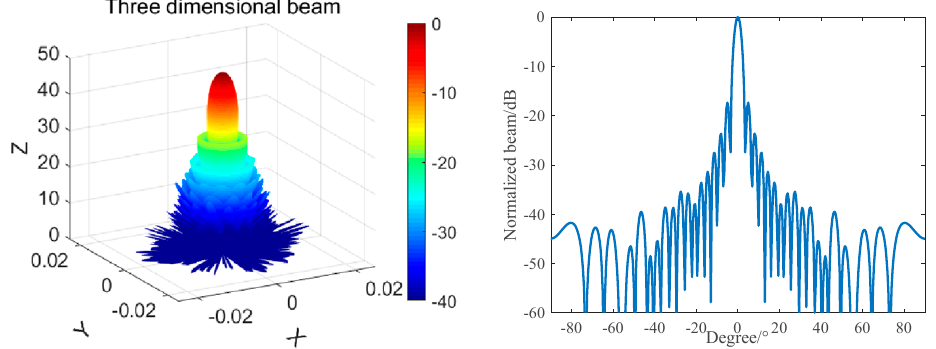
Figure 6. Beam of the Circular Transmitting Array with f = 390 kHz.